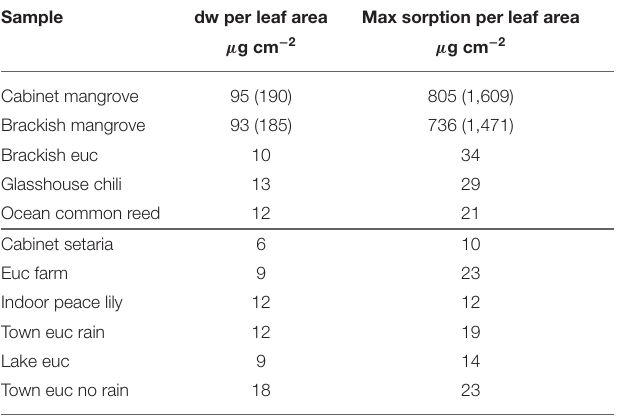
The cabinet mangrove sample comprised only 3 leaves so the scaled value from Table 4 has been utilized. The salt glands of the two mangrove species are located on the abaxial surface and as such are scaled by 2 (as shown in brackets). Samples above the central line are visibly deliquescent. the leaf surface will be able to deliquesce and form liquid water.